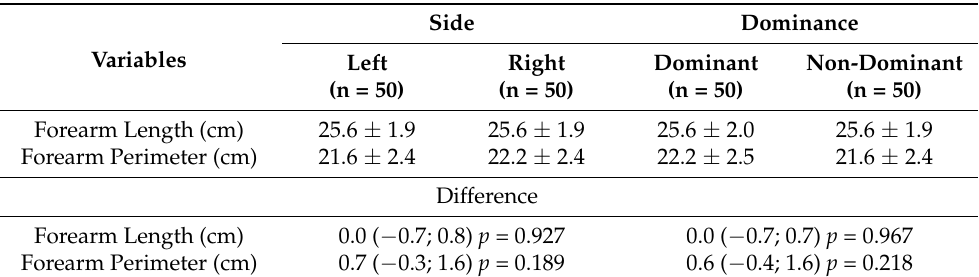
Table 2. Forearm anthropometric characteristic analyses by side and